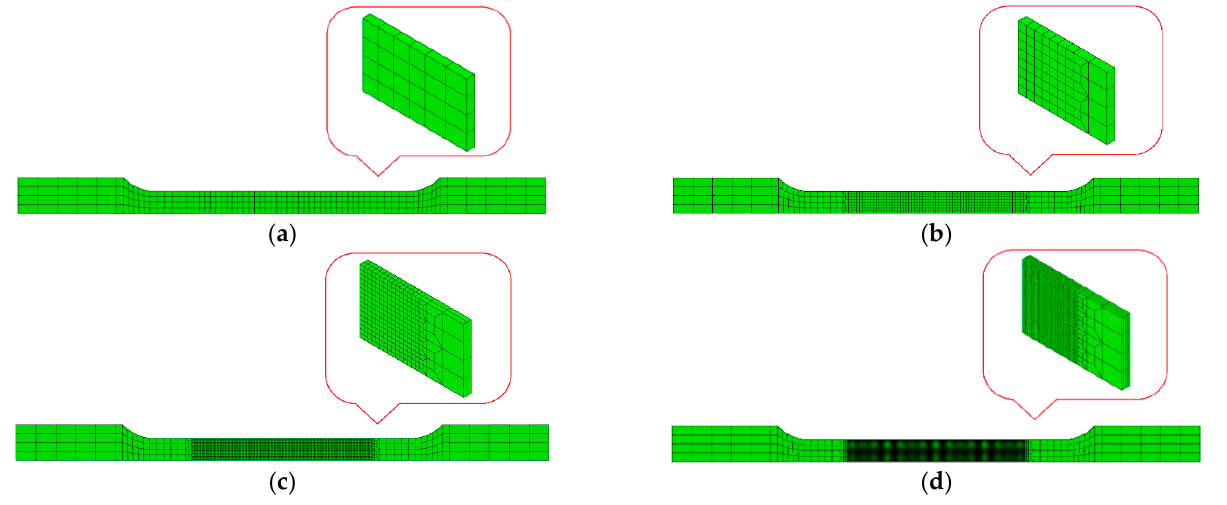
Figure 19. Different mesh sizes in the gauge length region of the uniaxial tensile specimen: ( a ) 1.6 mm, ( b ) 0.8 mm, ( c ) 0.4 mm, and ( d ) 0.2 mm.